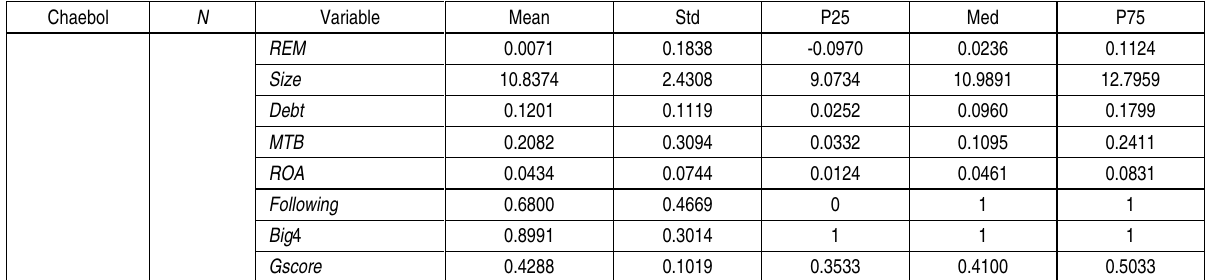
Table 1 (cont.). Summary statistics of key variables